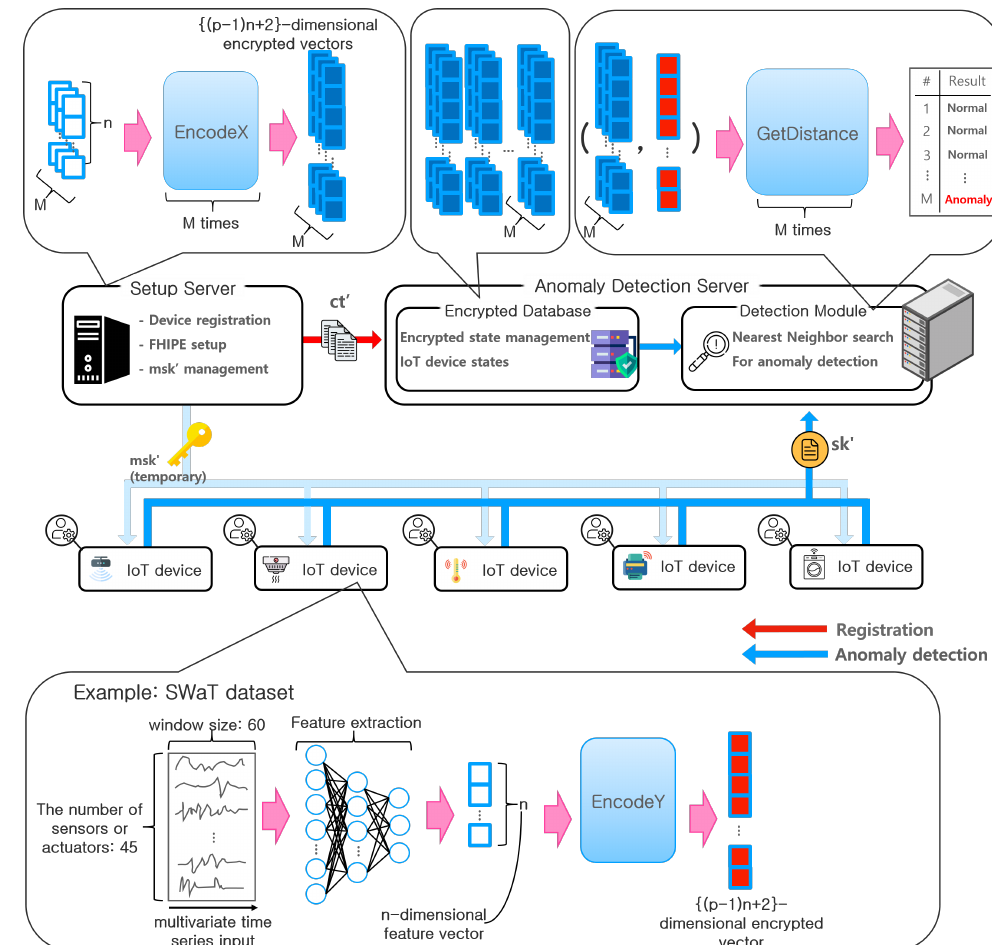
Figure 3. Example framework for privacy-preserving anomaly detection.